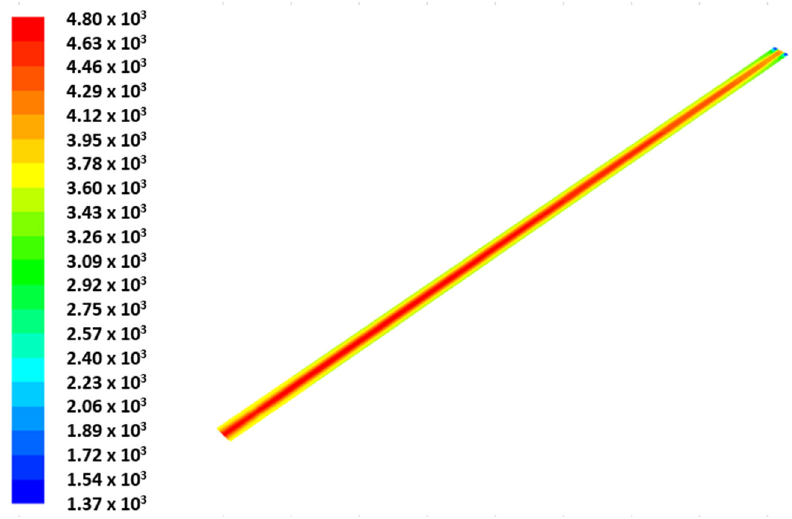
Figure 6. Current density (A/m 2 ) distribution contour of single-channel model.